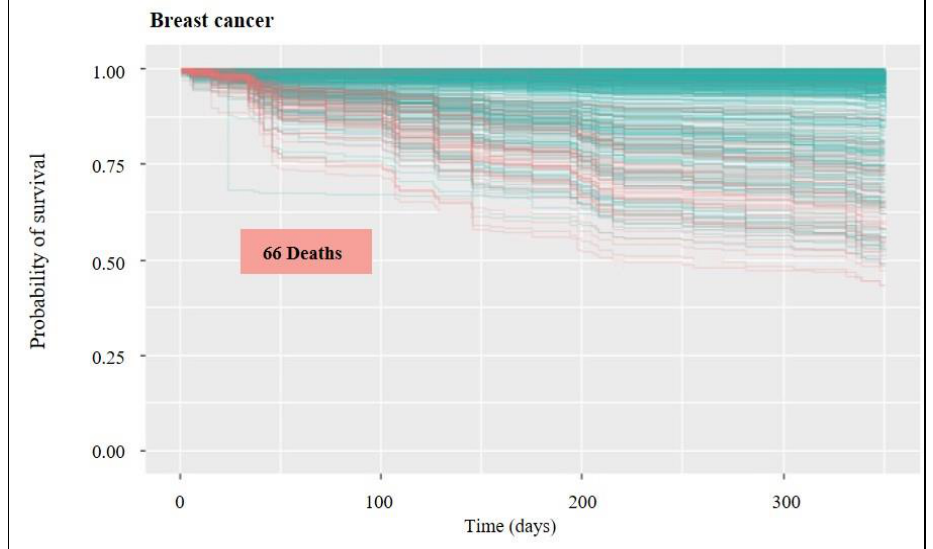
Figure 5. Survival for breast cancer: probability of survival over time for the untrained group of patients (out-of-bag group). In red lines is the forecast of death occurrences; in blue is survival.